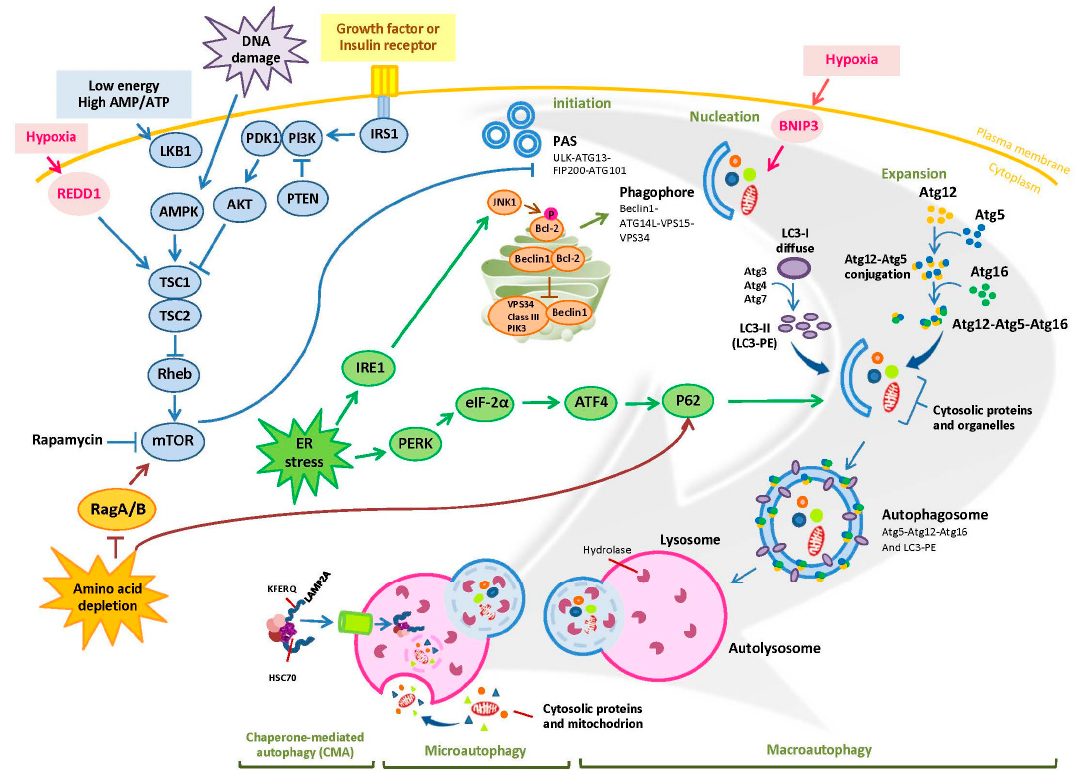
Figure 1. Diagram illustrates three types of autophagy, autophagosome formation, and autophagic signaling. Three types of autophagy, macroautophagy, microautophagy, and chaperon-mediated autophagy (CMA) have been found in eukaryotic cells. Macroautophagy is the most common type found in mammalian cells which proceeds through several steps including initiation, nucleation, expansion/elongation to form autophagosome, and fusion of autophagosome-lysosome to become autolysosome. These steps are performed by autophagy-related (Atg) proteins and other autophagic proteins, and regulated by different types of stress and signals, such as DNA damage, endoplasmic reticulum (ER) stress, growth factors or insulin, hypoxia, and amino acid depletion.